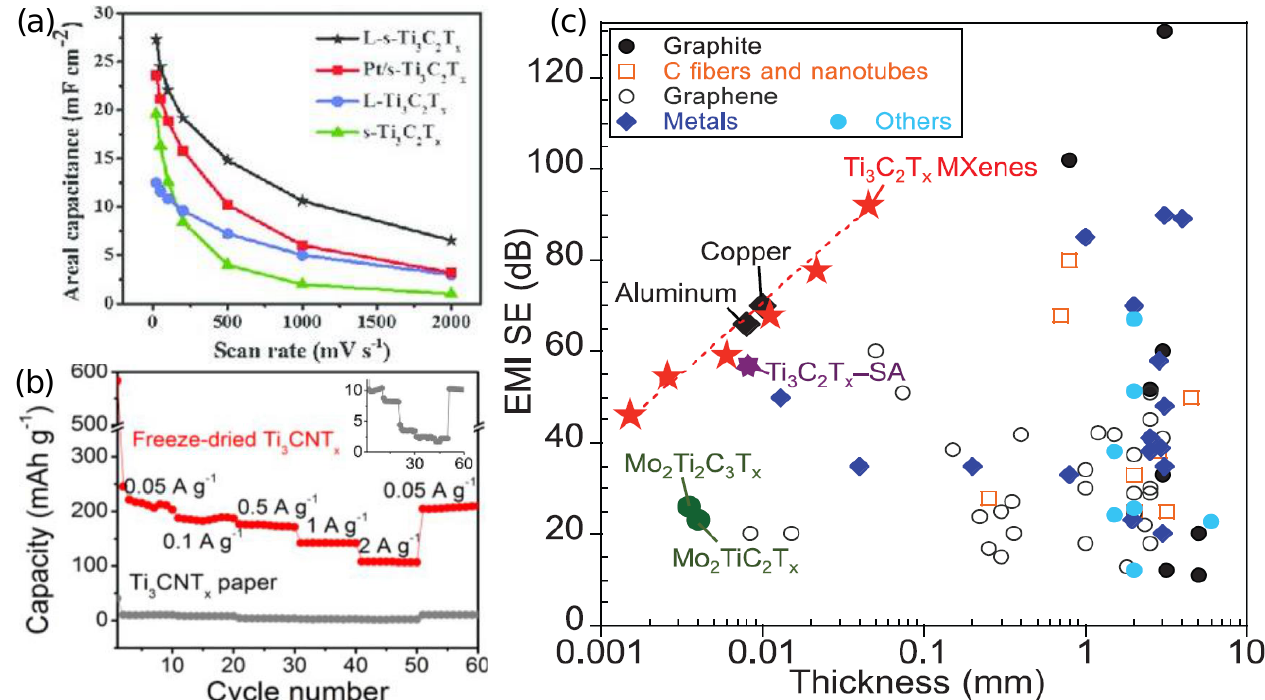
Figure 14. ( a ) Large Ti 3 C 2 T x (L-Ti 3 C 2 T x ) and small Ti 3 C 2 T x (s-Ti 3 C 2 T x ) are used as a current collector and active material [169]. ( b ) Discharge capacity of both freeze-dried and vacuum-dried Ti 3 CNT x at different cycling numbers [174]. ( c ) Comparison of EMI SE of Ti 3 C 2 T x and others at different thicknesses